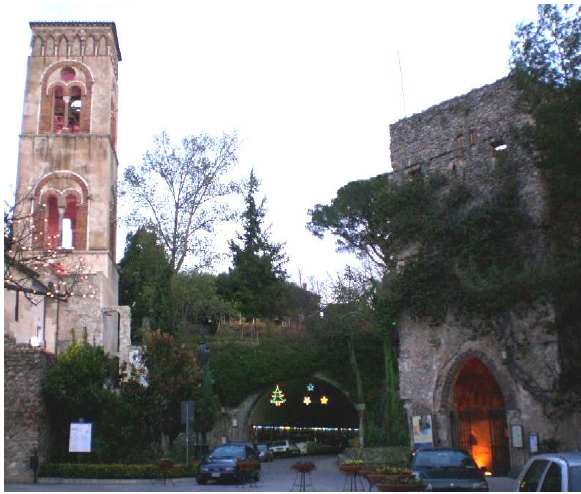
Figure 1. The bell tower and the entrance of Villa Rufolo